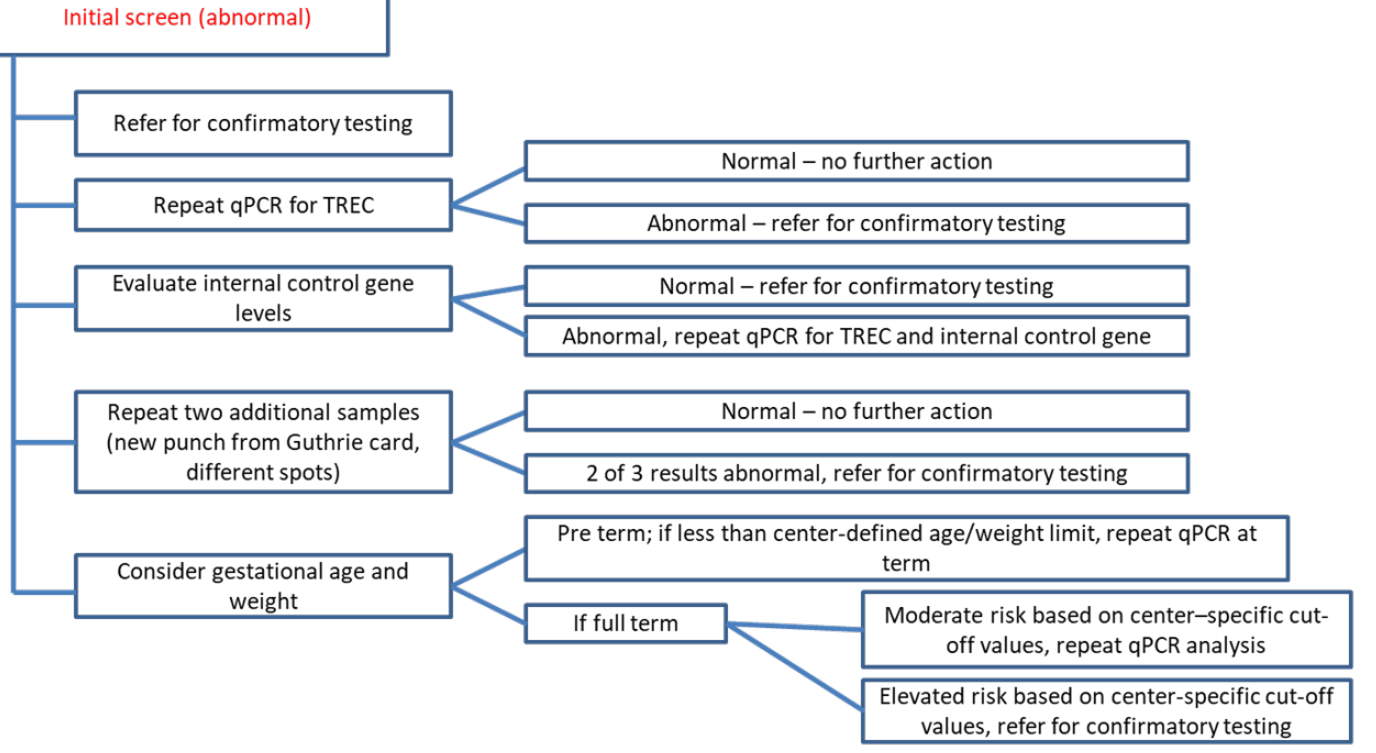
Figure 5. Variations on follow up practices for an abnormal NBS SCID result. Based on our survey results, respondents followed a diverse set of approaches to follow up on an abnormal NBS SCID result.